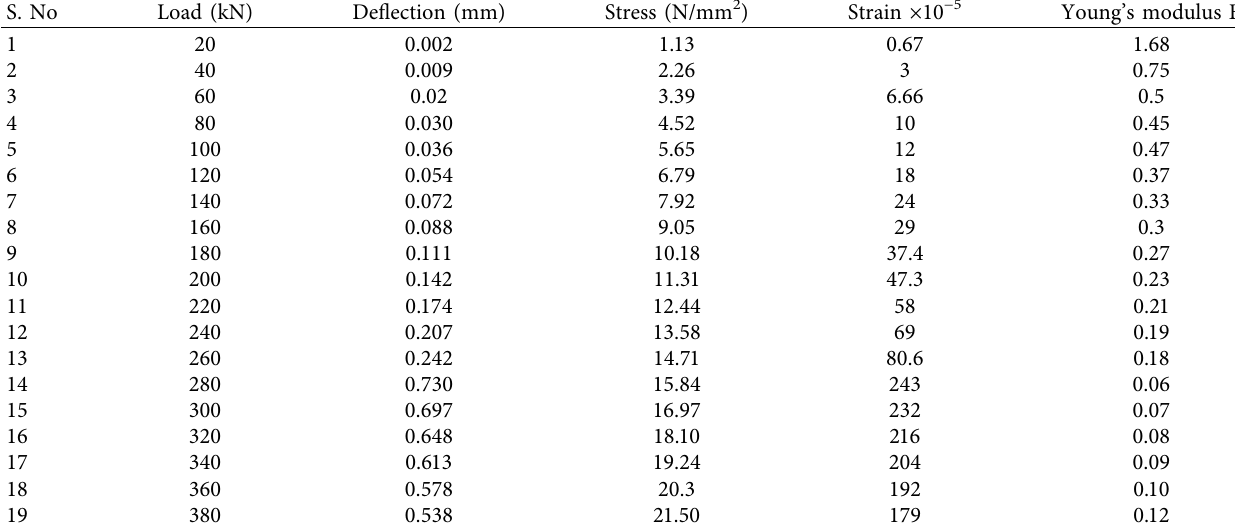
Table 5: Young’s modulus for M40 grade of the column with 0mm wrapping.